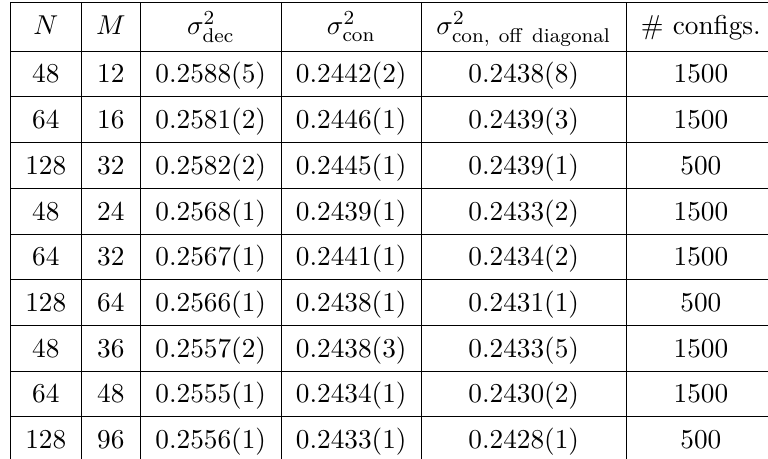
Table 3. The variances of ρ (X) and ρ (X) con in the constrained simulation, N = 48 , 64 and 128, dec T = 0 . 885 , with 24 lattice sites. The last column is the variance of the distribution of the off- diagonal block of the confined